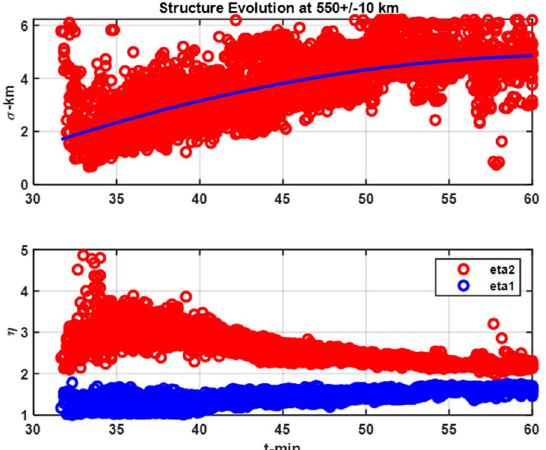
Fig. 6 Progression of height-dependent break scale (upper frame) and spectral index at 550